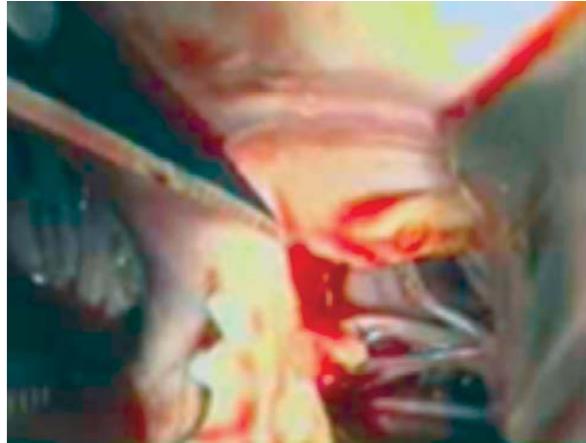
Fig. 4 - Comissurotomia anterior da valva mitral. Observação